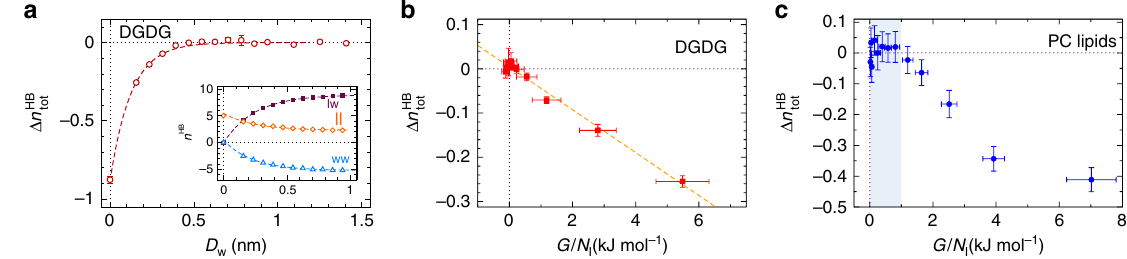
n w n HB , see main ww (cid:3) bw